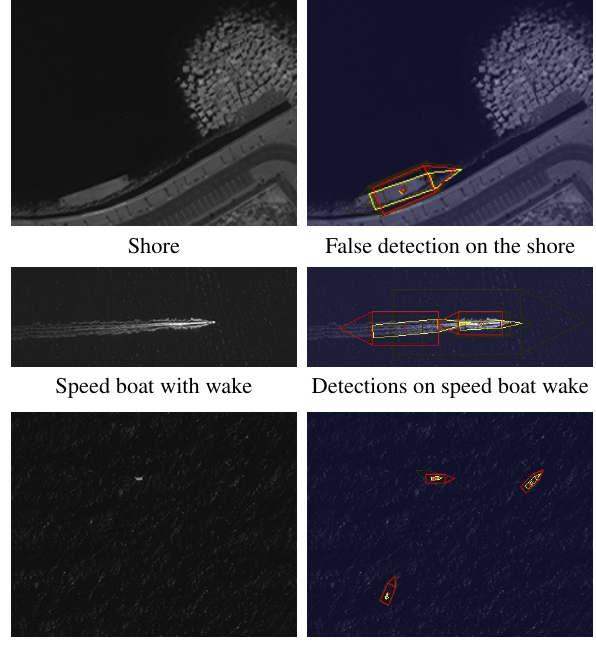
Figure 8: The typical problematic